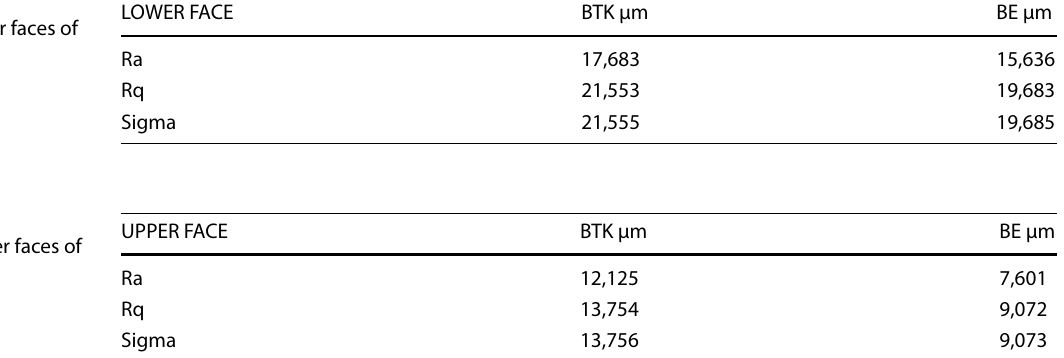
Fig. 3 Chemical composition per number of counts of Bone Easy mesh. As it was expected Titanium; Aluminium and Vanadium are present in the samples but Carbon is